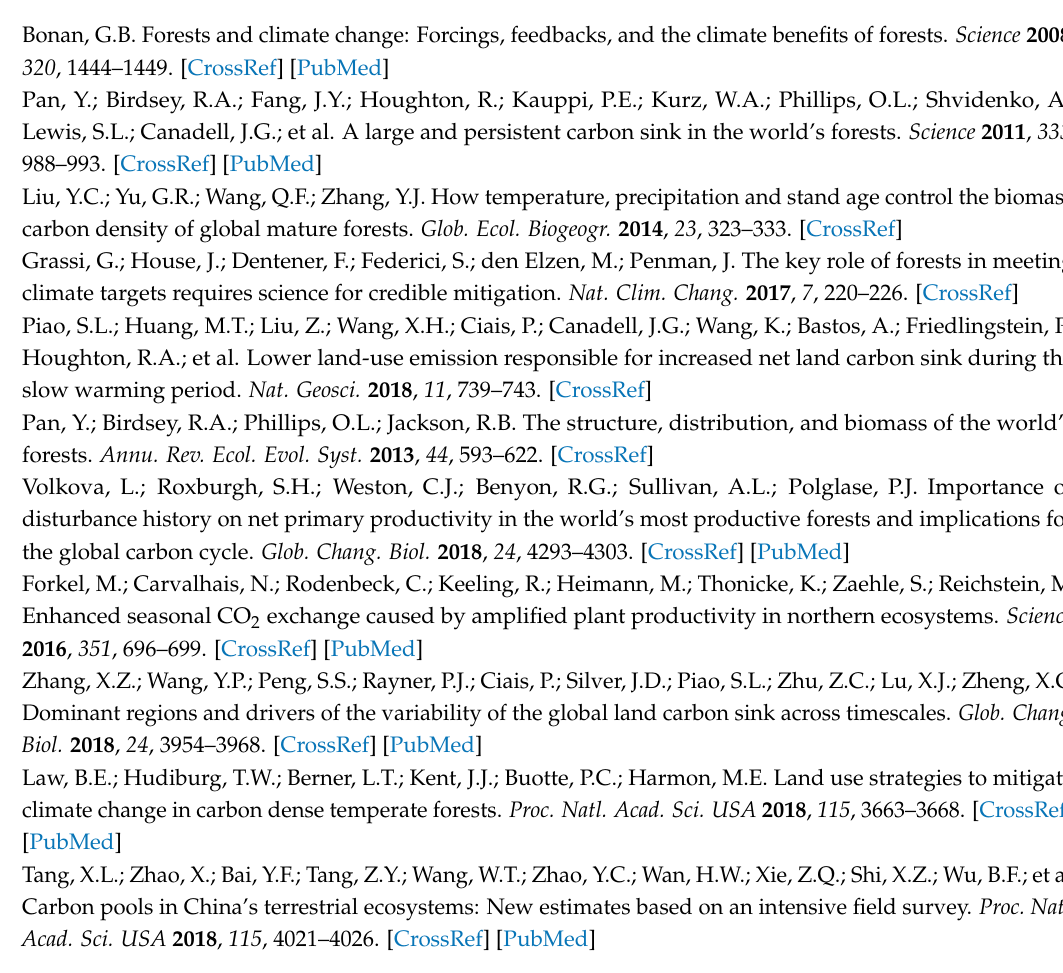
Table S1. Classification of forest ages for different forest types in China; Table S2. Projected forest area by 2050 in China; Table S3. Projected area of newly planted forests of different forest types during the period of 2010 − 2050 in China; Table S4. Projected forest area, biomass carbon stock, carbon density, and BCS for five different age classes between 2010 and 2050 in six regions of China; Table S5. Projected forest area, biomass carbon stock and carbon density between 2010 and 2050 in different provinces of